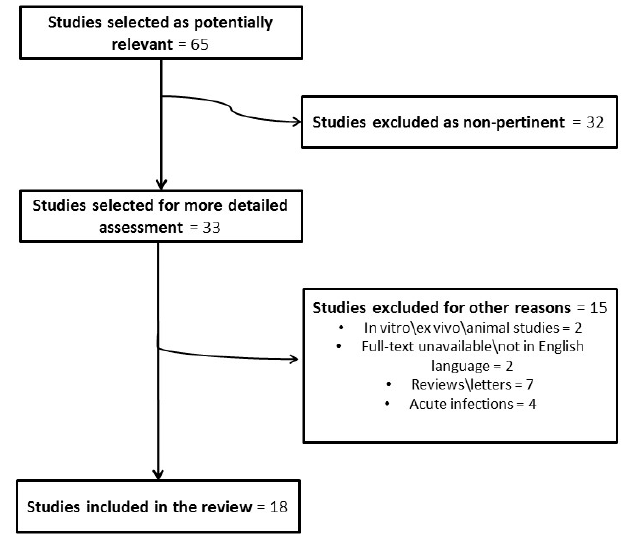
Figure 2. Flowchart of article selection (biofilms in recurrent/chronic middle ear disease).